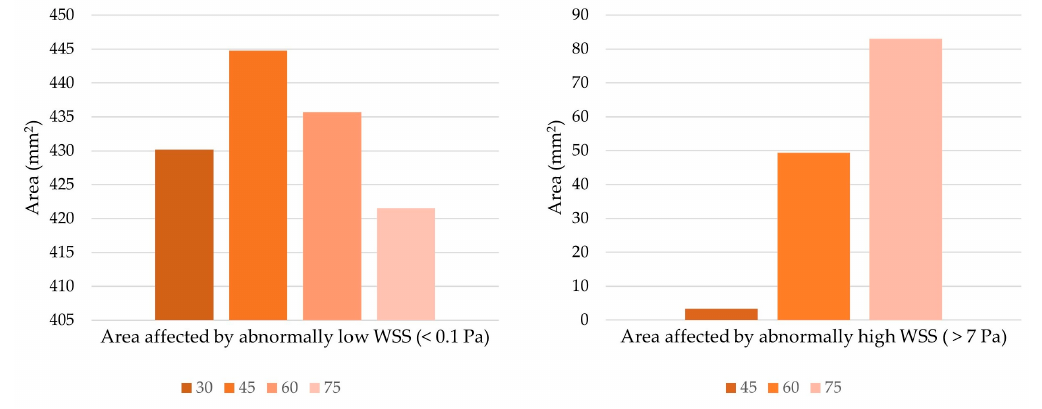
Figure 10. Extent of the area a ff ected by abnormal WSS. The 30-degree anastomosis angle resulted in the total elimination of abnormally high WSS, so it is not present in the chart on the right.